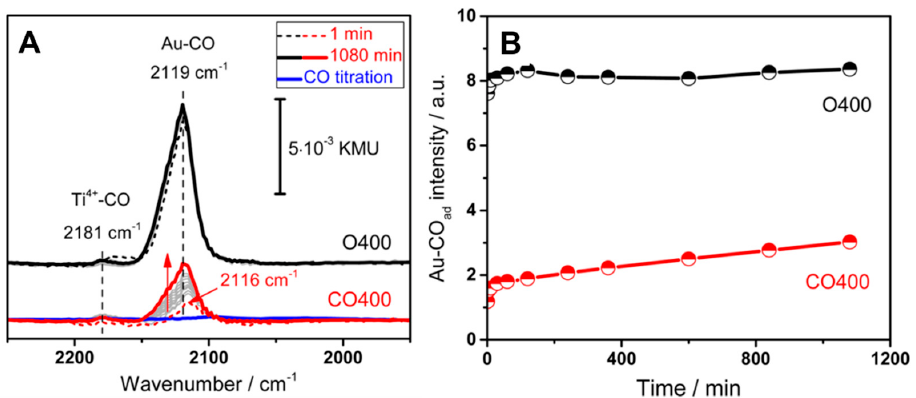
Figure 6. ( a ) Sequence of in situ DRIFT spectra recorded during CO oxidation (1% CO, 1% O 2 , balance N 2 ) on Au/TiO 2 at 80 °C directly after in situ pre-treatment at 400 °C in oxidative (O400: 10% O 2 /N 2 ) or reductive (CO400: 10% CO/N 2 ) atmosphere. For comparison, we also show a spectrum recorded during CO adsorption (1% CO, balance N 2 , 10 min) on a CO400 catalyst. For all spectra, the gas phase CO signal is already subtracted. ( b ) Temporal evolution of the CO ad band intensity during these measurements. Reprinted with permission from Reference [43]. Copyright 2017, American Chemical